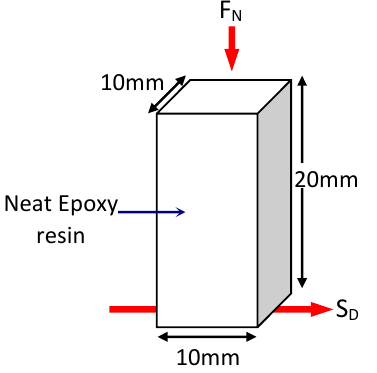
Figure 4. Schematic illustration of the Neat Epoxy (NE) test specimen.